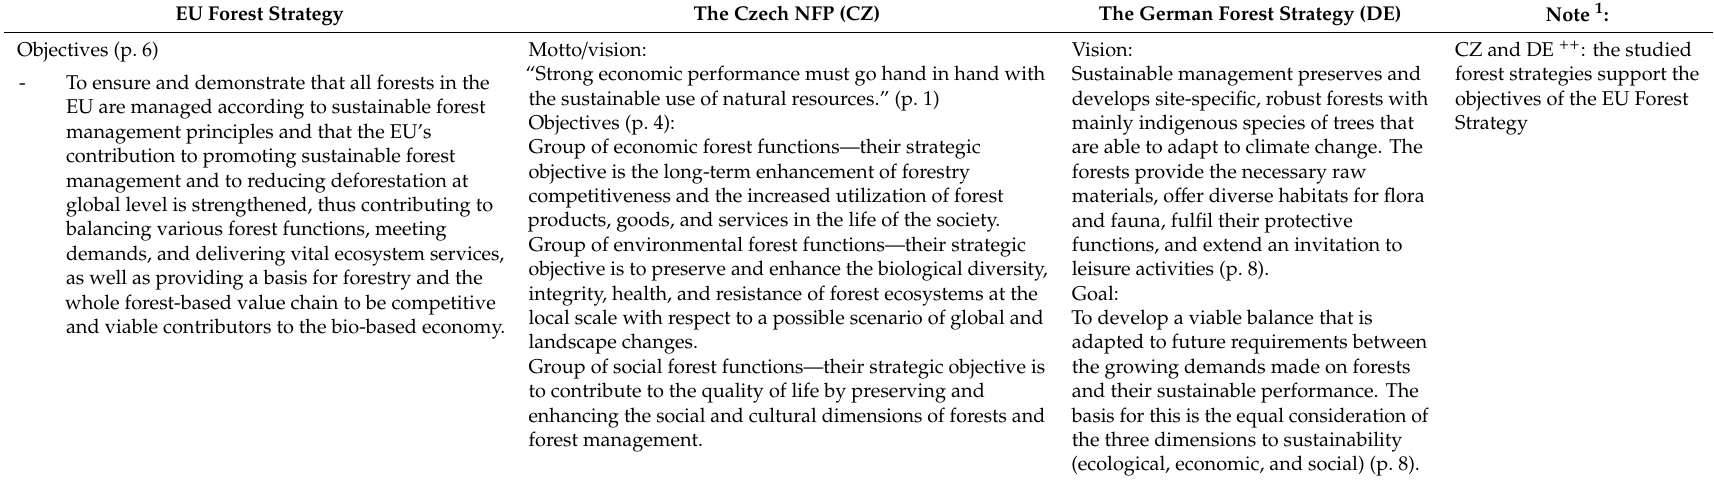
Table A1. Comparison of visions, goals or objectives of the forest strategy in Germany and the Czech Republic, as well as their relationship with the EU forest strategy. EU Forest